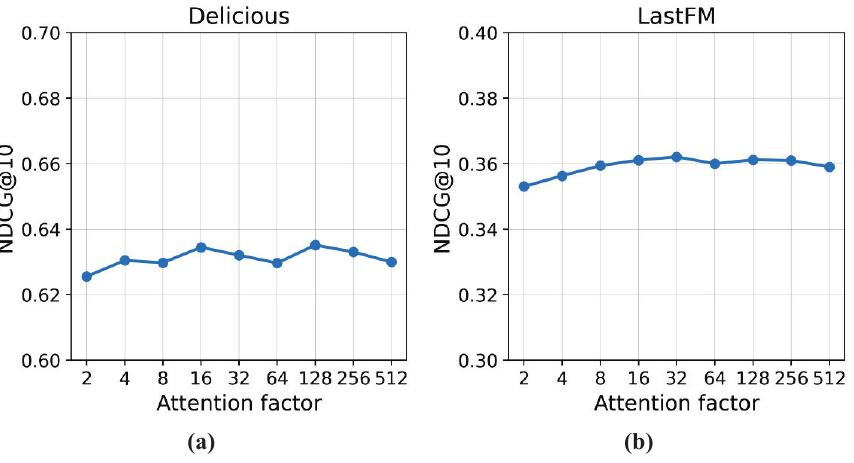
Figure 4. Recommendation results of different attention factors. ( a ) NDCG@10 on Delicious. ( b ) NDCG@10 on LastFM.